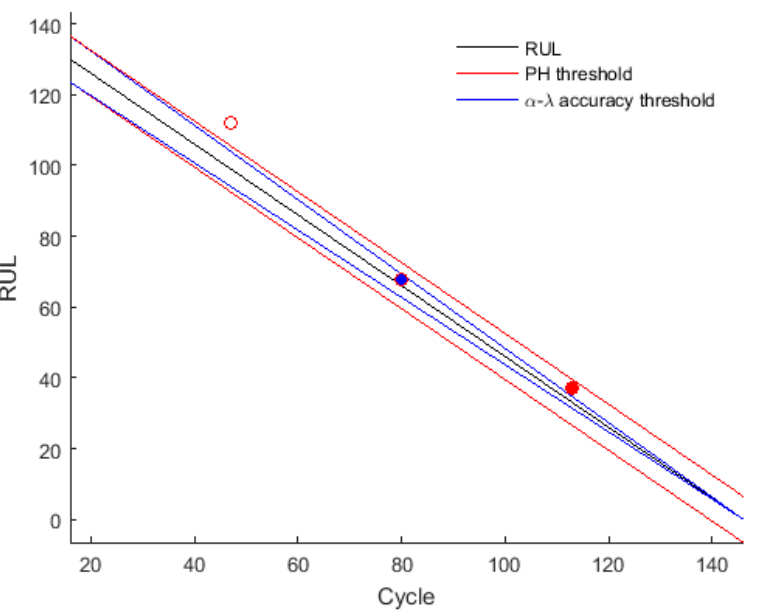
Figure 1. Qualitative response. The black line represents the ground truth; the red lines represent the α boundaries of PH ( 𝜶 𝟏(cid:2878) and 𝜶 𝟏(cid:2879) ); the blue lines represent the α boundaries of the α - λ accuracy ( 𝜶 (cid:2878) and 𝜶 (cid:2879) ); the empty circle represents a prediction with a probability mass within 𝜶 (cid:2878) and 𝜶 (cid:2879) lower than 𝜷 ; the blue point represent a prediction with a probability mass within 𝜶 (cid:2878) and 𝜶 (cid:2879) equal or greater than 𝜷 ; the red point represents a prediction with a probability mass within 𝜶 (cid:2878) and 𝜶 (cid:2879) less than 𝜷 but with a probability mass within 𝜶 𝟏(cid:2878) and 𝜶 𝟏(cid:2879) equal or greater than 𝜷 .